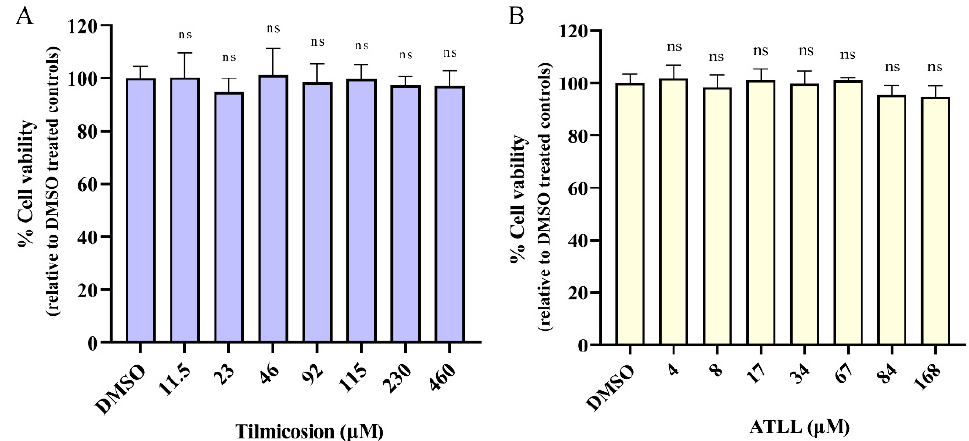
Figure 1. Cytotoxic concentrations of tilmicosin and ATLL. Different concentrations of tilmicosin ( A ) or ATLL ( B ) were treated on Vero cells for 24 h, and then cytotoxicity was determined using CCK-8 reagent. The absorbance was measured at 450 nm. Data are expressed as mean ± SD in triplicate. ns = not significant, indicating statistically insignificant results, as determined by t -test.